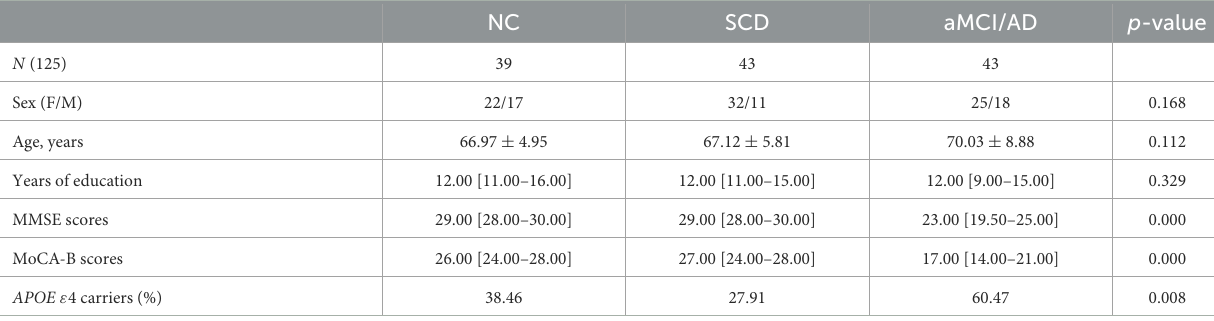
TABLE 1 Demographic and clinical characteristics of